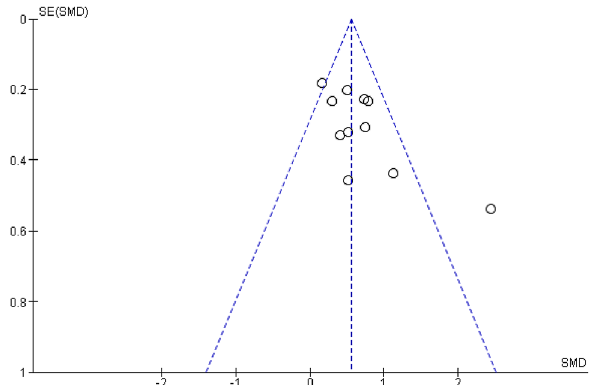
Figure 3. Funnel plot of standardized between-group OLP vs. NT scores. Funnel plot of standardized mean difference (SMD) vs. standard error (SE). The dotted lines indicate the triangular region within which 95% of studies are expected to lie in the absence of publication